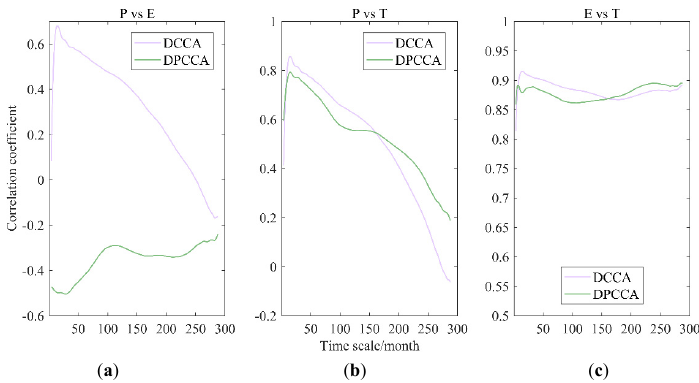
Figure 4. Cross-correlation coefficients among P, E, and air temperature (T) obtained by DCCA cross-correlation coefficient and DPCCA, i.e., P-E ( a ), P-T ( b ), and E-T ( c ).